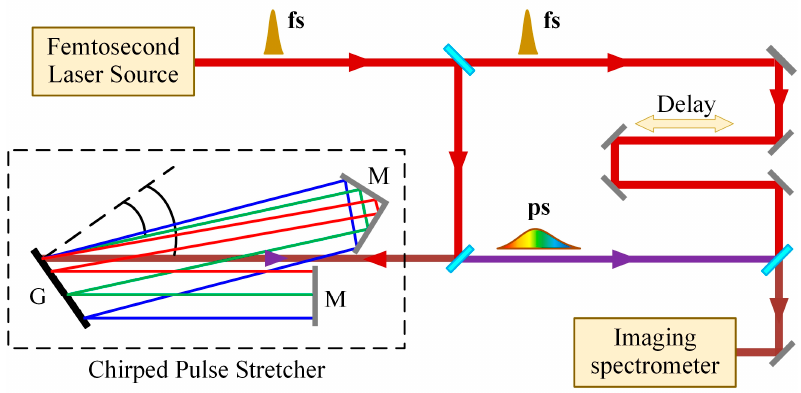
Figure 7. The optical path employed in the temporal chirp experiment.